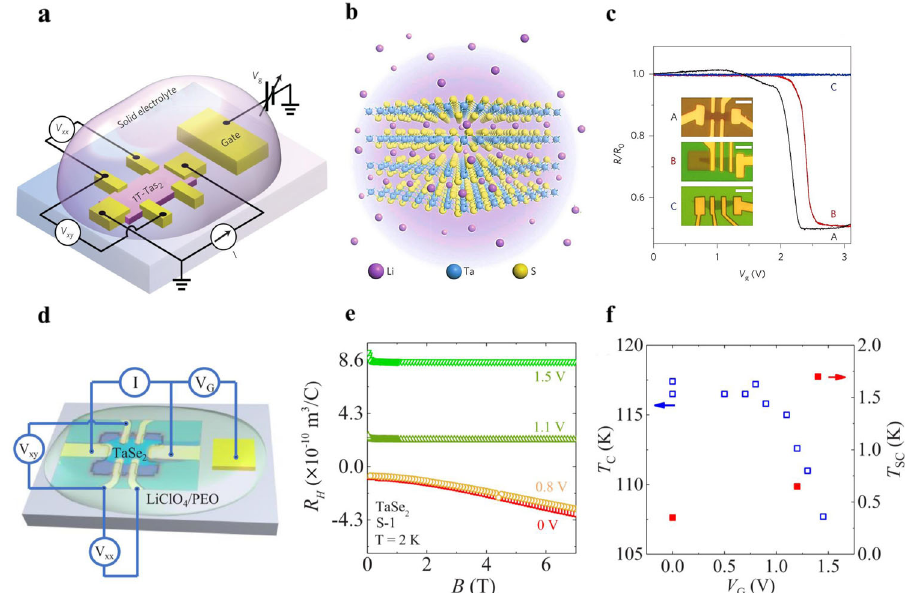
Fig. 4 Gate-controlled intercalation effects on 1T-TaS 2 /2H-TaSe 2 . a Schematic measurement setup of 1T-TaS 2 iFET. b Schematic of Li intercalation into layered 1T-TaS 2 . c Resistance R (normalized to its initial value R 0 ) of 1T-TaS 2 thin fl akes during an up-sweep of V g at T = 325 K. Sample A (black curve) is fully exposed to solid electrolyte, corner of sample B (red curve) is exposed while the region between electrodes was covered by a layer of PMMA and sample C (blue curve) is fully protected by PMMA 153 . Superconductivity and CDW in 2H-TaSe 2 . d sample con fi guration and optical image of a real device. e Hall coef fi cient R H as a function of magnetic fi eld for the 10-nm-thick sample at various gate voltages for